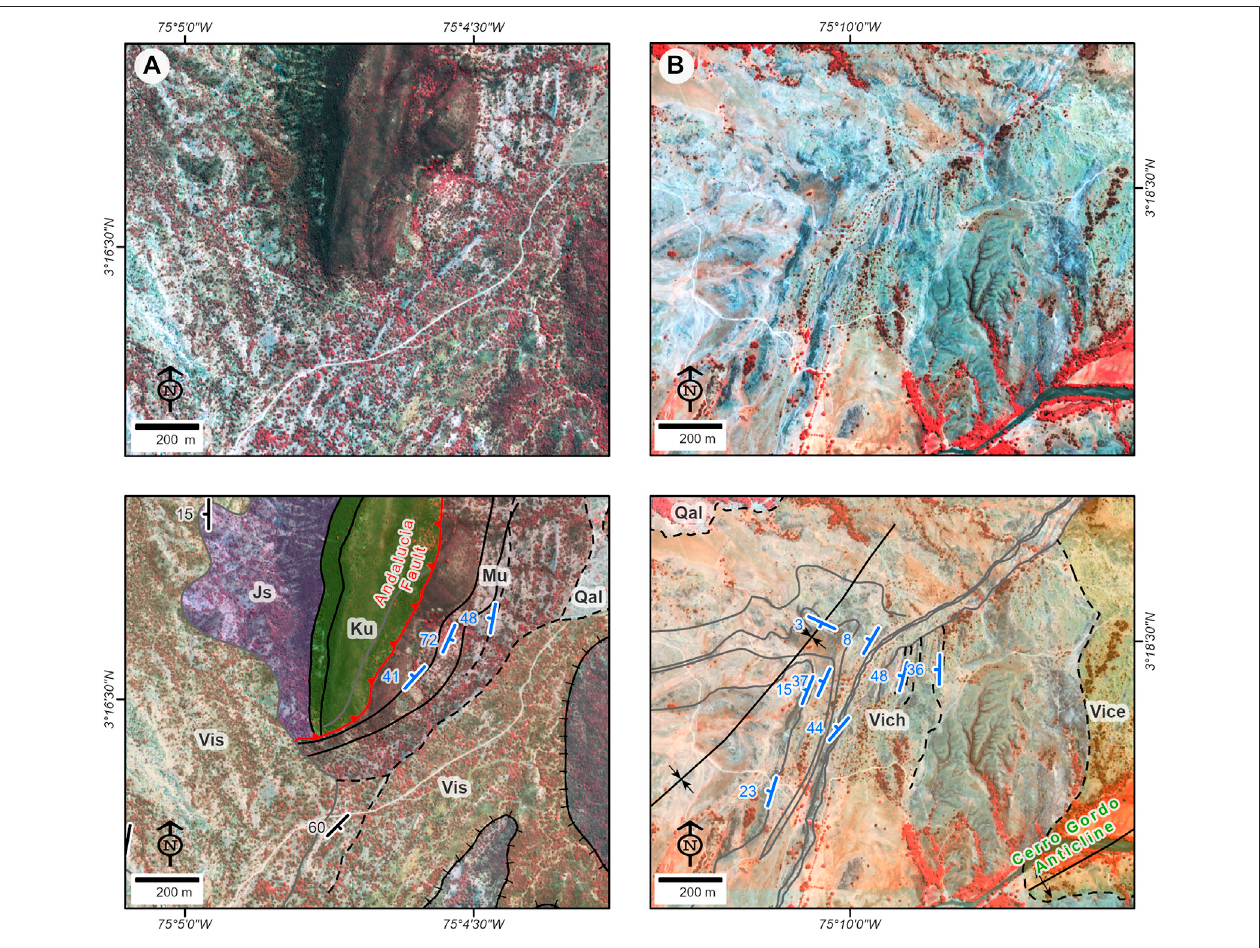
FIGURE 6 | Close ups of the geologic map ( Figure 4 ) to highlight key crosscutting fi eld relationships. (A) Satellite image (top) and geologic contacts (bottom) showing the trace of the Andalucia Fault fossilized by strata of the San Alfonso Beds. (B) Satellite image (top) and geologic contacts (bottom) showing the truncation of strata (growth unconformity) near the axis of the Cerro Gordo growth anticline. Images are Pleiades natural color composite images. All symbols as in Figure 4 .